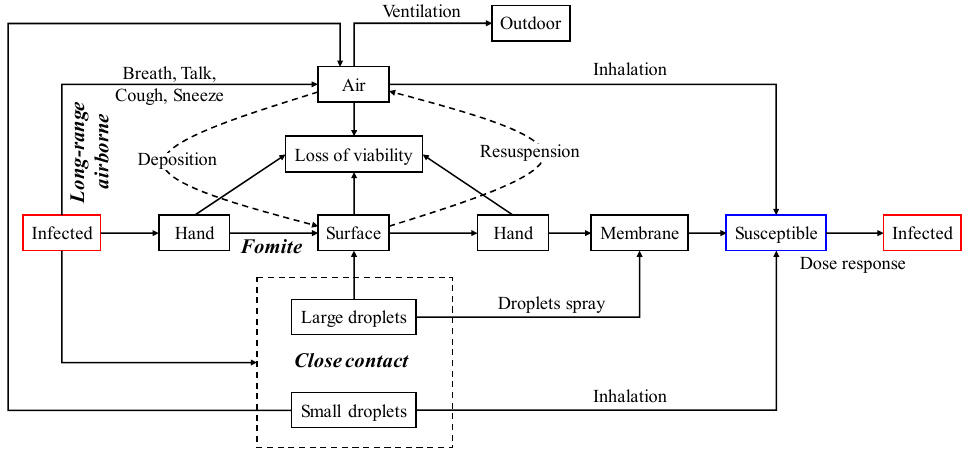
Figure 1. Three routes for influenza A transmission.